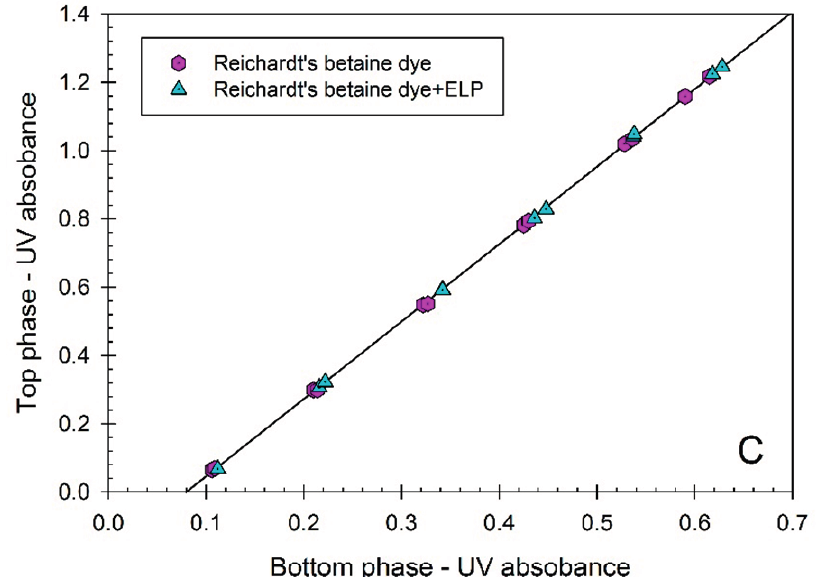
Figure 2. ( A ) Concentration of p -nitrophenol (represented by UV absorbance at 404 nm) in the top phase vs. concentration of p -nitrophenol (represented by UV absorbance at 404 nm) in the bottom phase of aqueous Ficoll-PEG-0.01 M sodium phosphate buffer, pH 7.4 two-phase system. p -Nitrophenol was partitioned in the absence of additives, and in the presence of ELP, (GVGVP) 40 . Concentrations of p -nitrophenol are measured in each phase following dilution with universal buffer, pH 12.4. Slope of the linear curve represents the partition coefficient of p -nitrophenol; ( B ) Concentration of p -nitroanisole (represented by UV absorbance at 318 nm) in the top phase vs. concentration of p -nitroanisole (represented by UV absorbance at 318 nm) in the bottom phase of aqueous Ficoll-PEG-0.01 M sodium phosphate buffer, pH 7.4 two-phase system. p -Nitroanisole was partitioned in the absence of additives, and in the presence of ELP, (GVGVP) 40 . Concentrations of p -nitroanisole are measured in each phase following dilution with water. Slope of the linear curve represents the partition coefficient of p -nitroanisole; ( C ) Concentration of the carboxylated Reichardt’s betaine dye (represented by UV absorbance at 308 nm) in the top phase vs. concentration of the carboxylated Reichardt’s betaine dye (represented by UV absorbance at 308 nm) in the bottom phase of aqueous Ficoll-PEG-0.01 M sodium phosphate buffer, pH 7.4 two-phase system. Carboxylated Reichardt’s betaine dye was partitioned in the absence of additives, and in the presence of ELP, (GVGVP) 40 . Concentrations of the carboxylated Reichardt’s betaine dye are measured in each phase following dilution with water. Slope of the linear curve represents the partition coefficient of the carboxylated Reichardt’s betaine